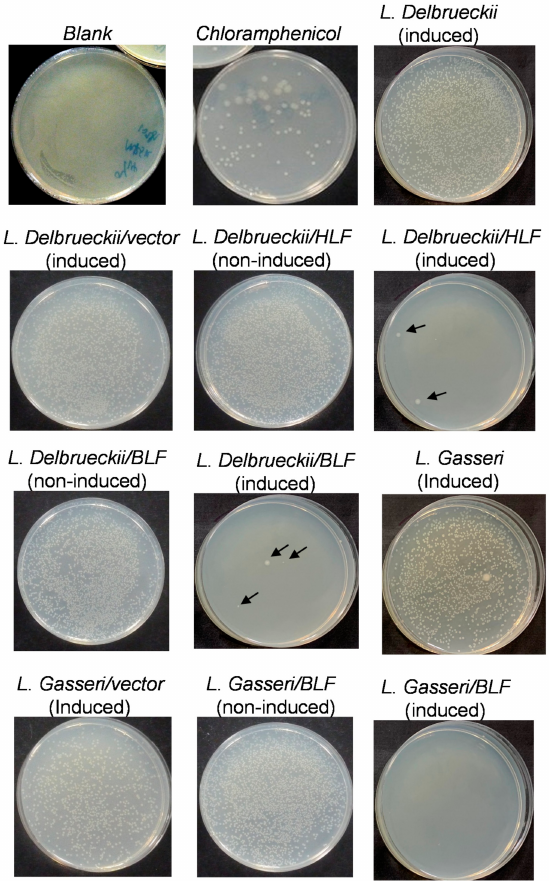
Figure 7. Effects of recombinant human or bovine lactoferrin cell lysates on the growth of Staphy- lococcus aureus . About 100 mL L. delbrueckii (host control), L. delbrueckii/ pNZ8148 (vector control), L. delbrueckii/HLF , L. delbrueckii/BLF , L. gasseri (host control) , L. gasseri/ pNZ8148 (vector control), and L. gasseri /BLF was induced by protein expression for 5 h using nisin. Cell pellets were harvested, washed by phosphate-buffered saline twice, and then disrupted by sonication. Supernatants (cell lysates) were then harvested by centrifugation. Supernatants (200 µ L/assay) were mixed with pathogenic bacterial broth (1 × 10 4 cfu/mL; 300 µ L) in Eppendorf, and these mixers were further incubated for 24 h at 37 ◦ C. Then, 200 µ L of the mixtures was further plated onto nutrient agar (NA) plates to reveal the remaining growth of bacterial colonies. Arrows indicate the grown of individual bacterial colonies. The final concentration of 12.5 µ g/mL chloramphenicol was also used as the control. The blank control presented as smear-type bacterial, revealing countless pathogenic bacterial colonies grown on the NA plates, and the induced L. delbrueckii /BLF, L. delbrueckii /HLF and L. gasseri /BLF almost completely blocked the growth of S. aureus on the NA